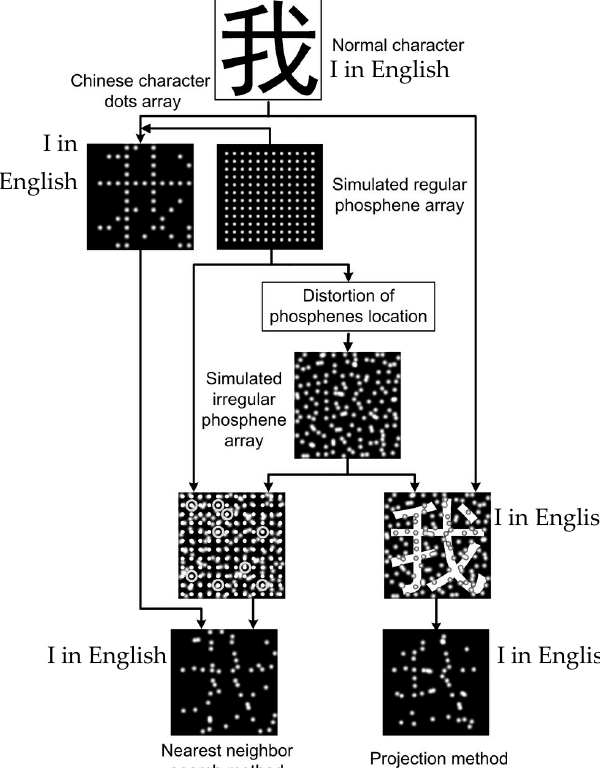
Figure 5. Two optimization strategy procedures (cited from [87]).